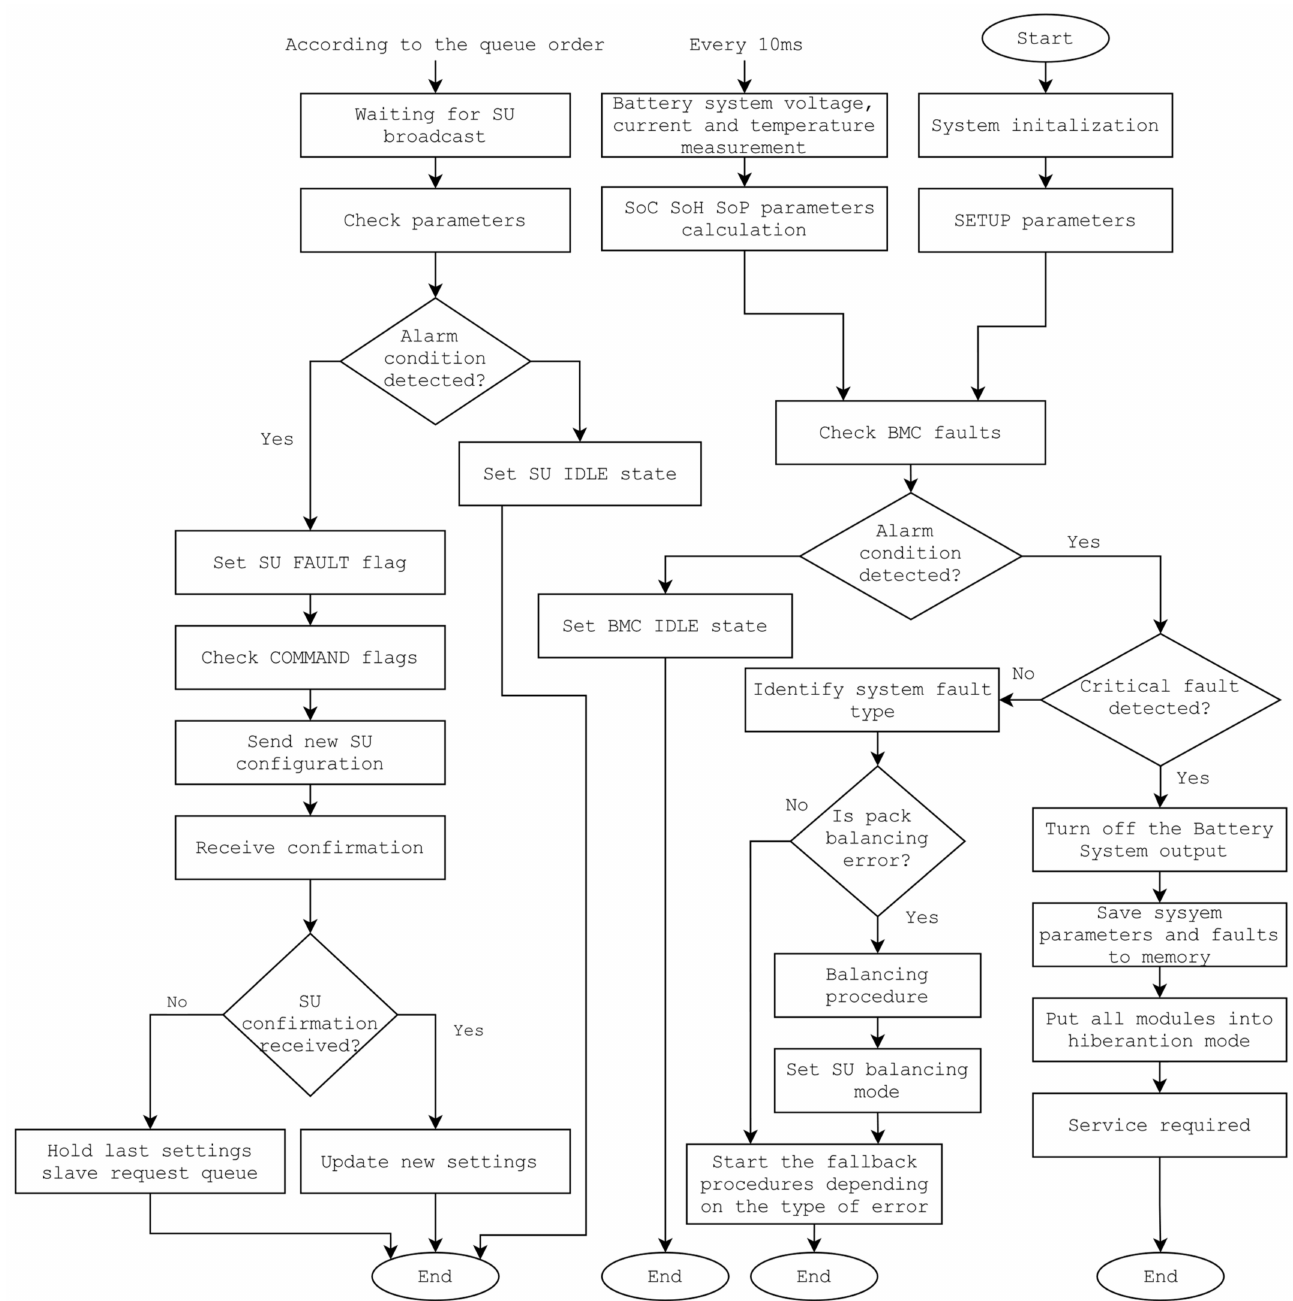
Figure 8. Algorithm illustrating the management process executed by the BMC. The BMC checks in the ongoing management process that the SU responds according to the prescribed schedule and analyzes the received data. The BMC is also equipped with its own voltage, current, and temperature measurement system, which collects information about the output parameters of the entire battery system needed to update the SoC and SoH parameters. The BMC analyzes collected data to detect alarm threshold limits or critical system errors. Appropriate procedures are executed if the errors are not critical (e.g., a charger disconnect, a load disconnect, start balancing, run the cooling system). A critical safety procedure is triggered when the monitored parameters are out of range. The BMC turns off unnecessary peripherals, all SUs are switched to power-down mode, and the error log is saved in the non-volatile memory. After the modules have entered the Power-Down mode, a service action is